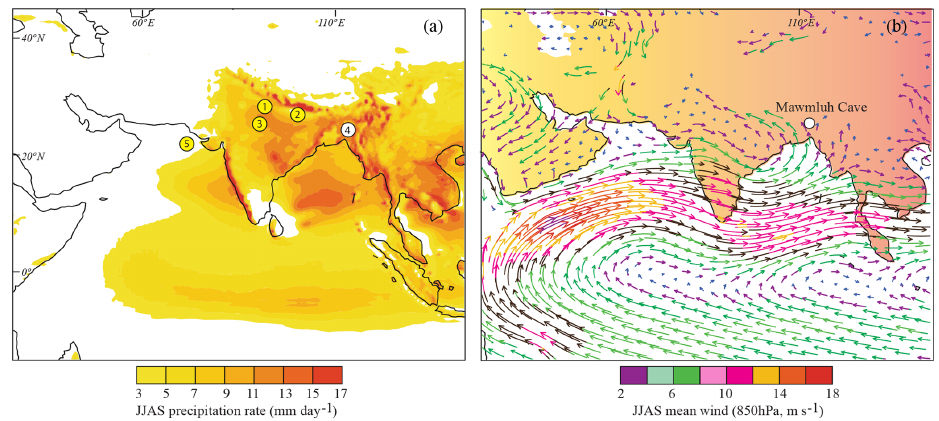
Figure 1. Location map and spatial structure of mean JJAS precipitation and low-level winds. (a) June–July–August–September (JJAS) precipitation from the Tropical Rainfall Measuring Mission (TRMM). The locations of Mawmluh Cave (white circle) and other proxy records mentioned in the text (yellow circles and numbers). The numbering scheme is as follows: 1, Sahiya Cave (Kathayat et al., 2017); 2, Lake Rara (Nakamura et al., 2016); 3, Kotla Dhar (Dixit et al., 2014); 4, Mawmluh Cave (Berkelhammer et al., 2012); and 5, Indus Delta (Staubwasser et al., 2003). (b) The 850hPa monsoon vector from zoomed Laboratoire de Meteorologie Dynamique (LMDZ) general circulation model with telescoping zooming (figure adapted and modified from Sabin et al., 2013). The zoom version shows a well-defined cyclonic circulation with westerlies on the southern flanks and easterly winds on the northern flanks of the monsoon trough. The Mawmluh Cave is ideally located to record upstream variations in the overall strength of the ISM (see